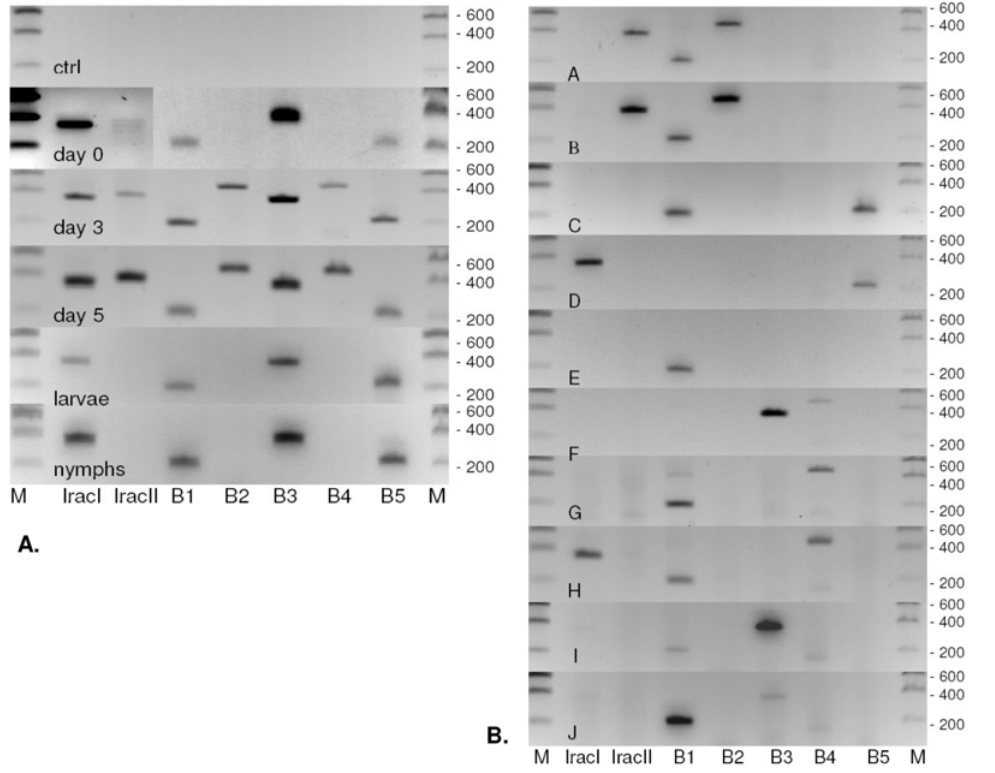
Figure 10. Expression patterns of individual IxACs. PolyA + RNA was extracted from various I. ricinus material as indicated and reverse transcribed. The resulting cDNAs were submitted to PCR analysis using pairs of primers specific for the indicated IxACs. Non- reverse transcribed polyA + RNA from the pool was included as negative control (Ctrl). PCR products were run on 1.2 % agarose gels. M, DNA size markers. B1 to B5, IxAC-B1 to IxAC-B5. Sizes in bp are indicated. Panel A: Analysis of salivary glands of a tick population (70 specimens, pool) and from individual female ticks at day 5 of the bloodmeal (A to J). Panel B: Analysis of pooled salivary glands of tick female populations at day 0 (25 specimens), day 3 (25 specimens) and day 5 (70 specimens) of the bloodmeal as well as from pooled gorged nymphs (25 specimens) and larvae (25 specimens).